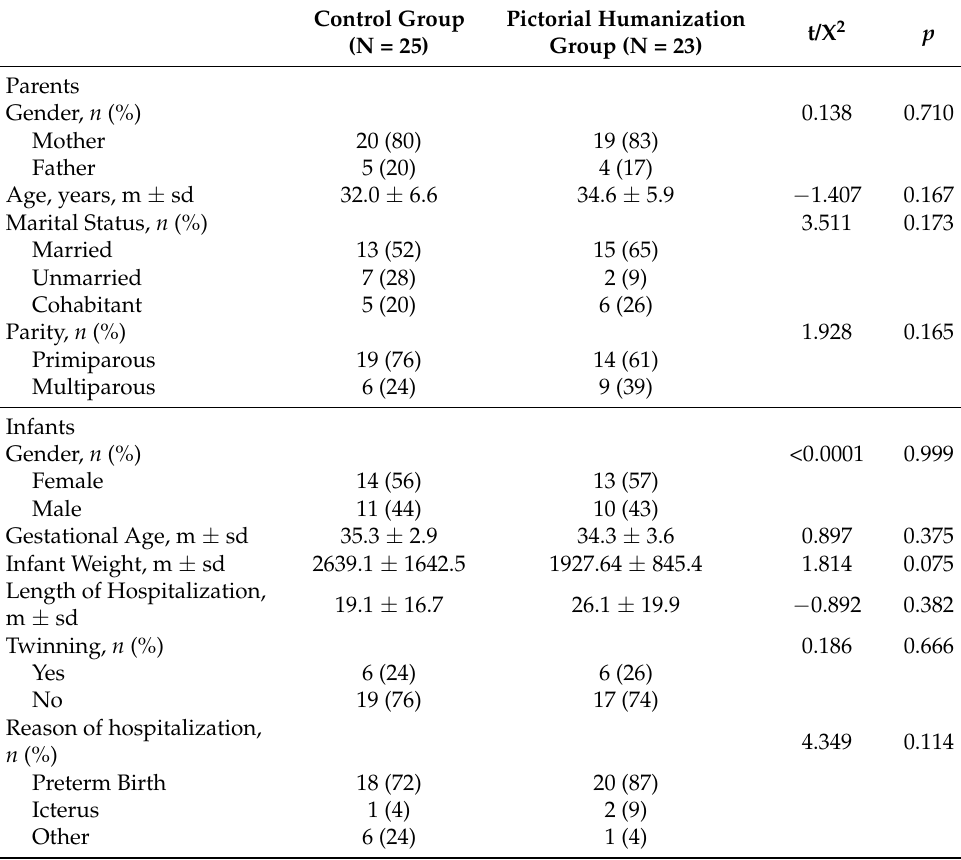
Table 1. Descriptive characteristics of sample.